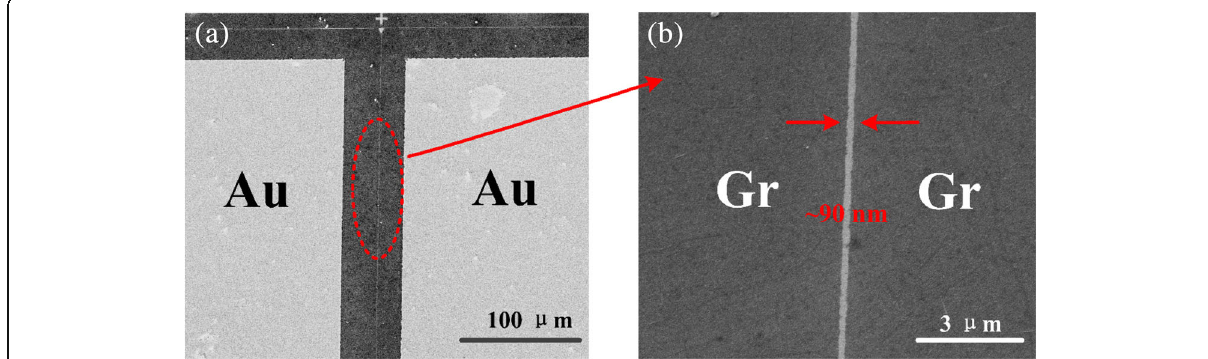
Fig. 4 SEM image of graphene-based NVCT with Au contacts ( a ). A zoom-in of the ~ 90 nm vacuum channel ( b